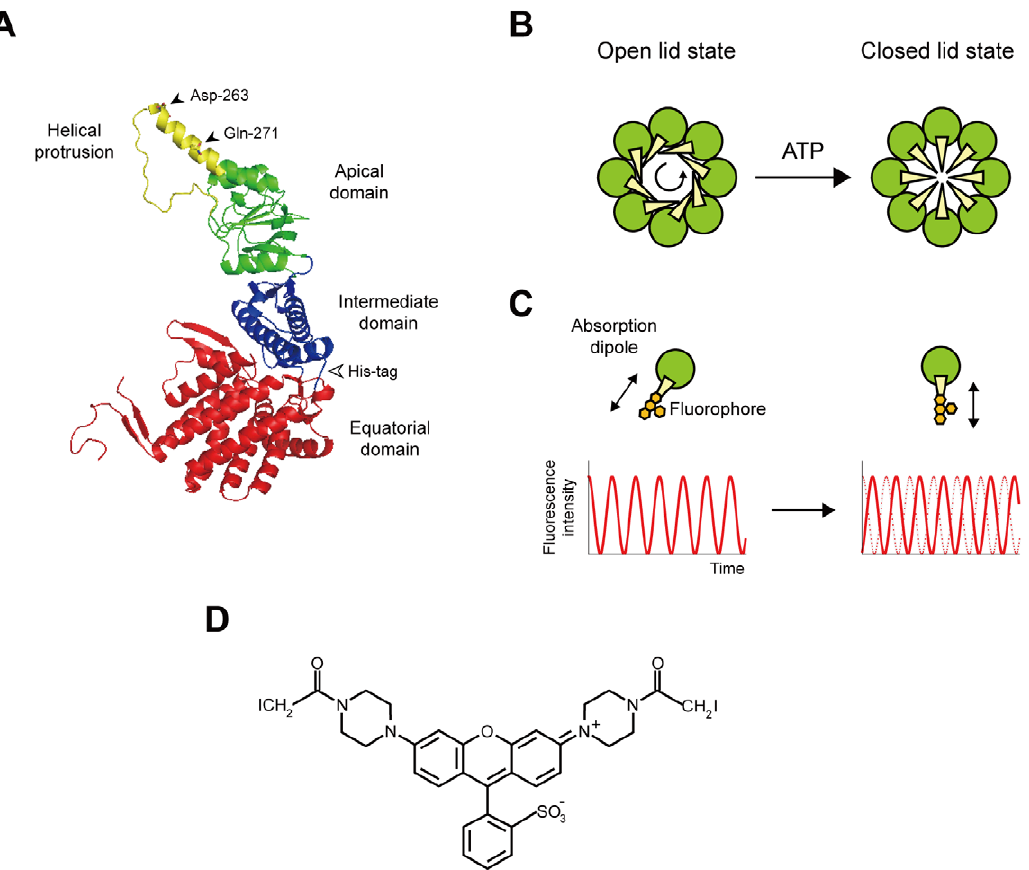
Figure 1. Model for the conformational transition from the open lid to the closed lid state in group II chaperonins and experimental design. ( A ) Subunit structure of T . KS-1 a chaperonin. The subunit has three distinct domains: equatorial ( red ), intermediate ( blue ), and apical ( green and yellow ). The helical protrusion is color-coded in yellow . Asp-263 and Gln-271 ( black arrowheads ) were mutated to cysteines, and were crosslinked with a bifunctional fluorophore. A His-tag was inserted into the loop, connecting the equatorial and intermediate domains ( white arrowhead ). The coordinates are from the Protein Data Bank code 1Q3S [12], and figures were drawn with the PyMOL program (http://pymol.sourceforge.net/). ( B ) Model for the conformational transition from the open lid to the closed lid state in the group II chaperonins [13,14,22]. ATP drives the conformational change from the open lid to the closed lid state. At this point, the counterclockwise rotation of the apical domains ( green ) orients the helical protrusions ( yellow ) toward the center of the cavity. ( C ) Expected intensity time courses for a single fluorophore bound to the helical protrusion. When a fluorophore is immobile, the fluorescence intensity oscillates as the excitation polarization is rotated ( red curve ). A phase shift is expected after reorientation of the fluorophore as a result of the rotation of the helical protrusion. ( D ) Structure of bis-(( N -iodoacetyl)piperazinyl)sulfonerho- damine (BSR).